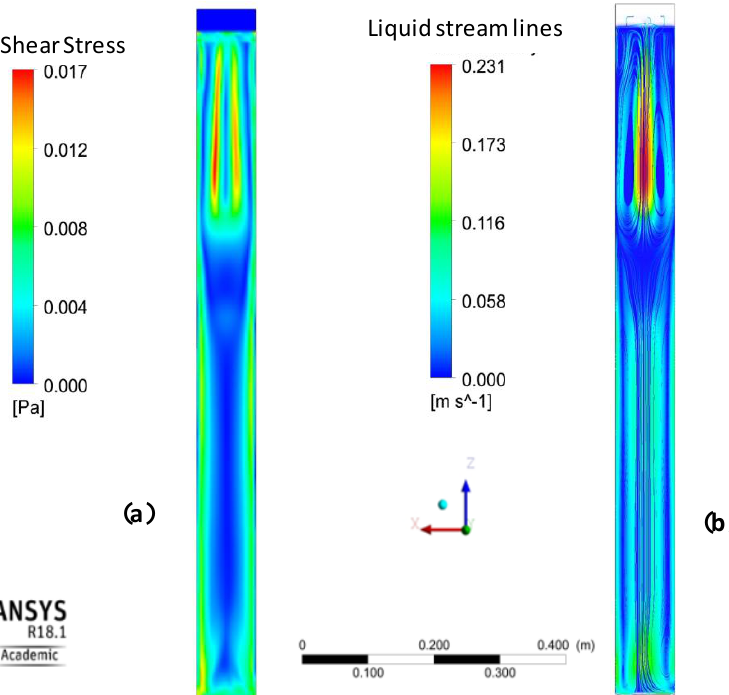
Figure 10. Typical CFD results at the middle plane of the bubble column: ( a ) Shear stress distribution; ( b ) Streamlines colored with the liquid phase velocity ( t = 5.8 s, U GS = 0.2 m/s, air-water, d p = 40 µ m, d c = 9 cm).